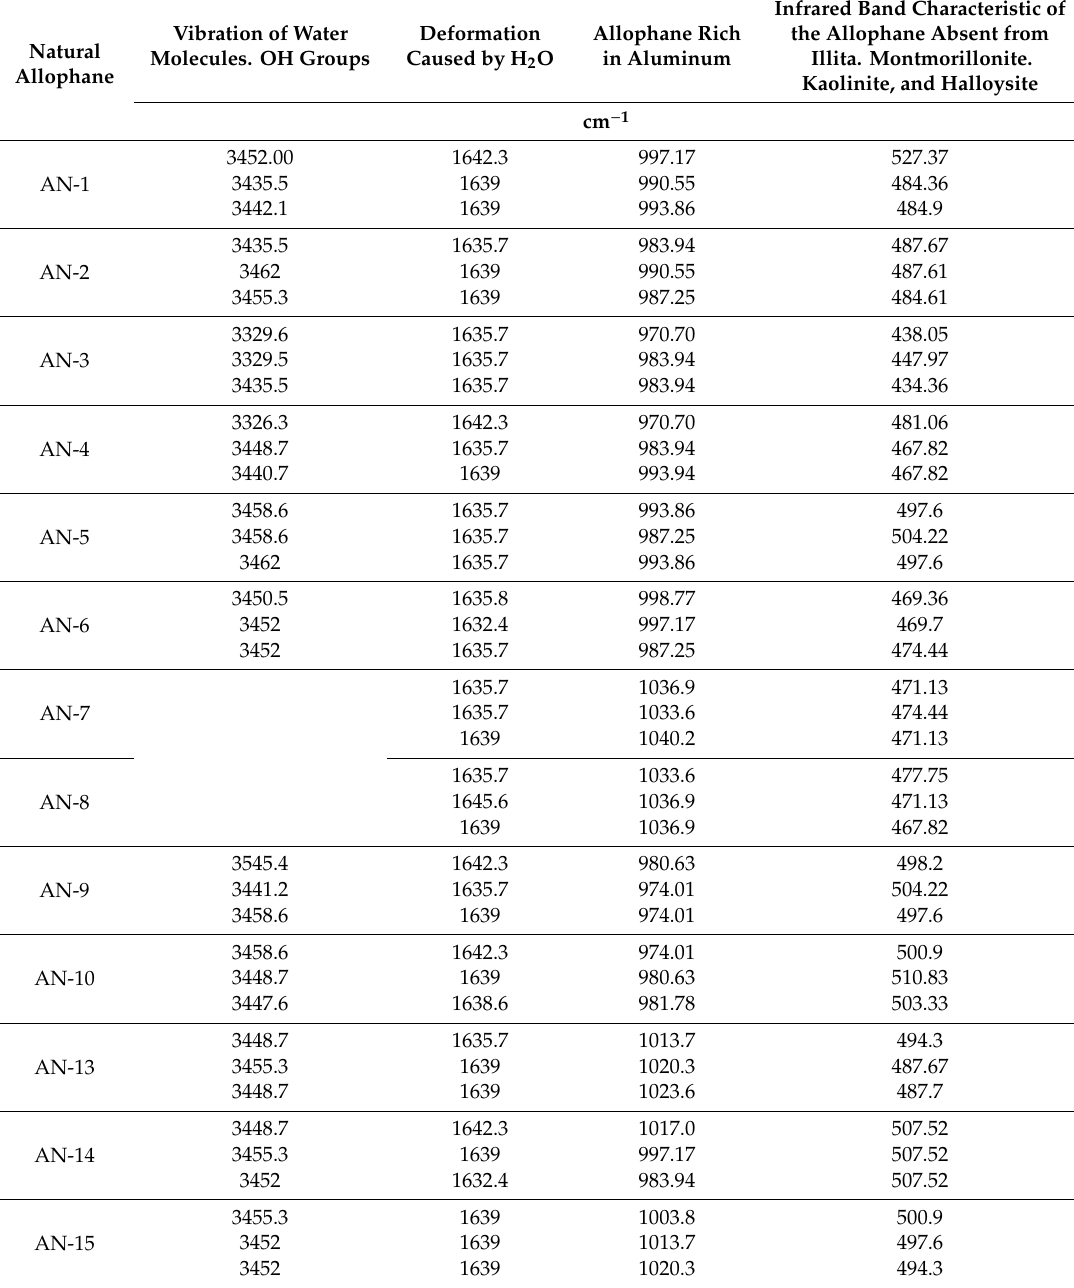
Table 4. FT-IR infrared spectra for main bands of natural